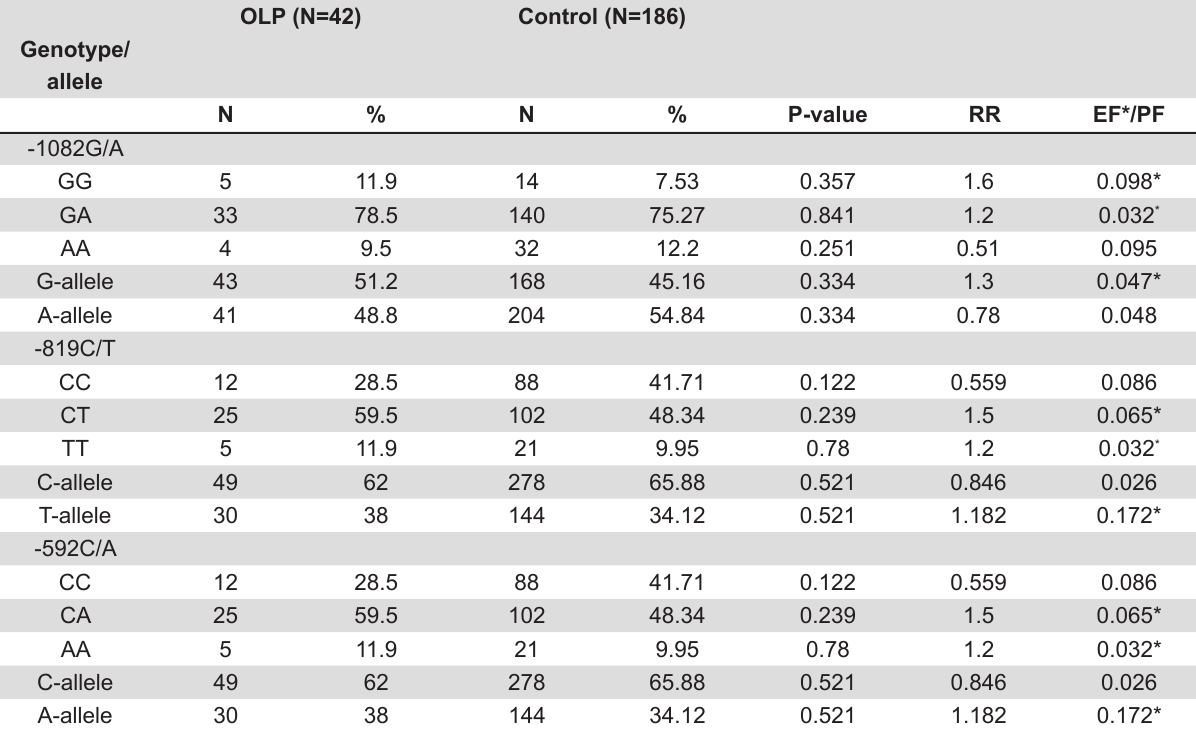
Table 2- Genotype and allele frequencies of IL-10 variants in oral lichen planus patients and matched controls